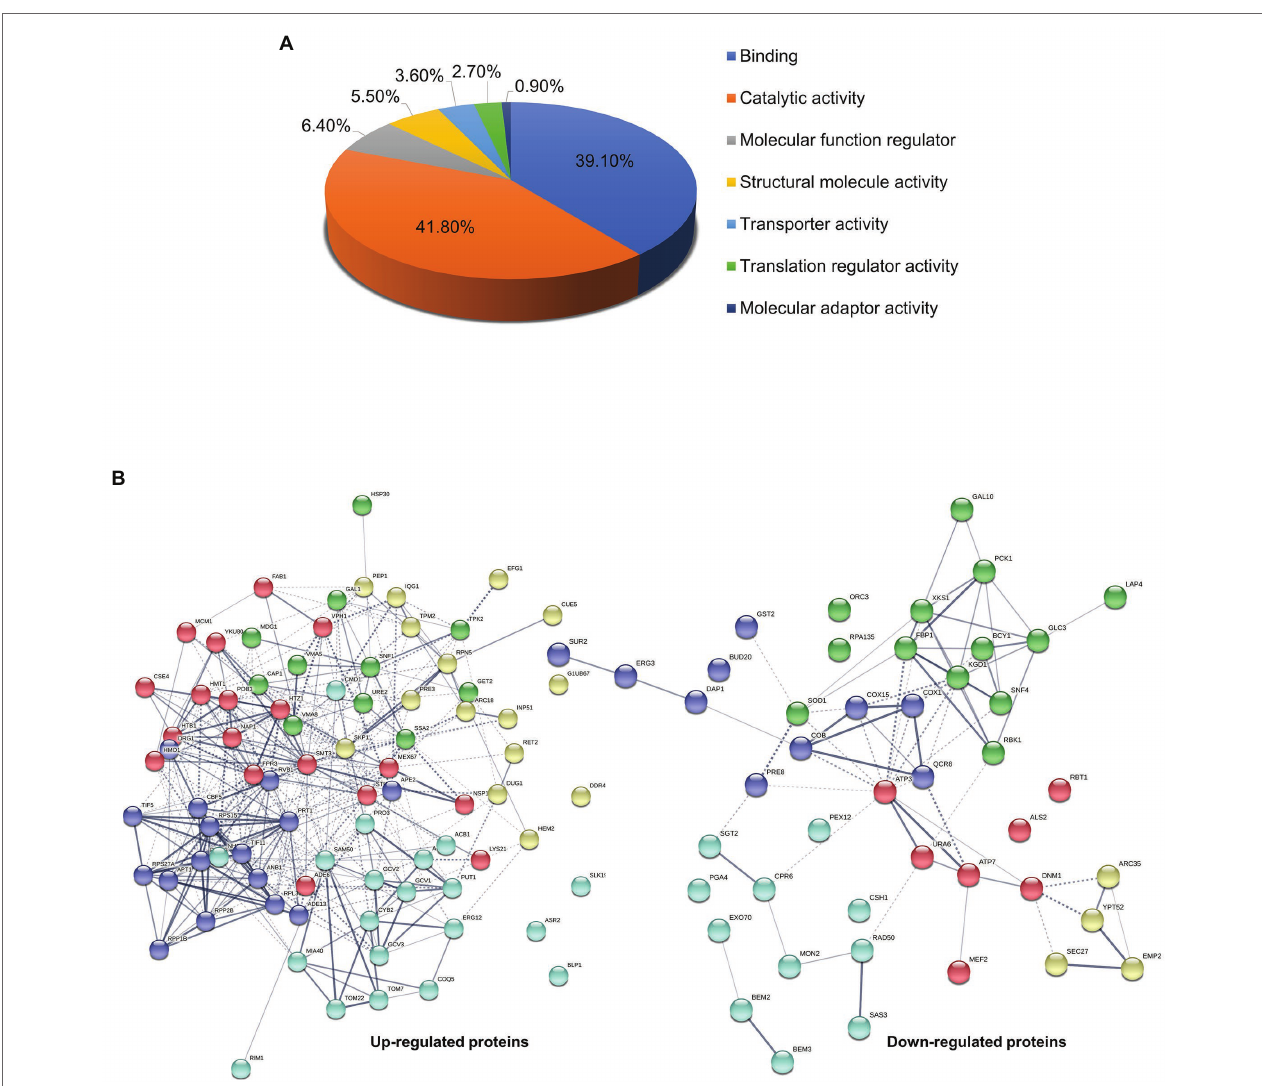
FIGURE 3 | Gene ontology classification and protein—protein interaction network analysis of Candida albicans influenced by β -citronellol treatment. (A) Molecular function group classification of both up- and downregulated proteins by PANTHER-GO database. (B) Prediction maps of protein-protein interaction network by STRING v.11 analysis. The interaction network nodes represents down- and upregulated protein found in this study, which illustrated the potential molecular pathways involved in the mode of action of β -citronellol. The colors of each node represent protein clusters as determined by the kmeans clustering